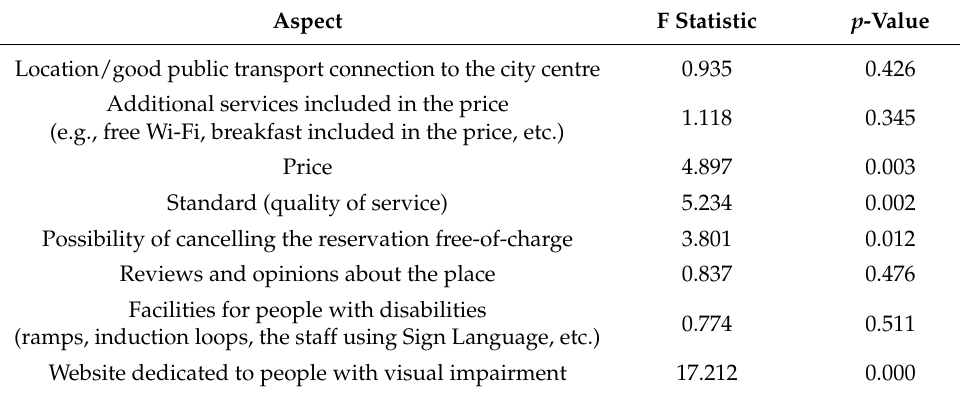
Table 12. Results of ANOVA for aspects influencing the choice of accommodation with respect to country. Aspect F Statistic p -Value Location/good public transport connection to the city centre 0.935 0.426 Additional services included in the price 1.118 0.345 (e.g., free Wi-Fi, breakfast included in the price, etc.) Price 4.897 0.003 Standard (quality of service) 5.234 0.002 Possibility of cancelling the reservation free-of-charge 3.801 0.012 Reviews and opinions about the place 0.837 0.476 Facilities for people with